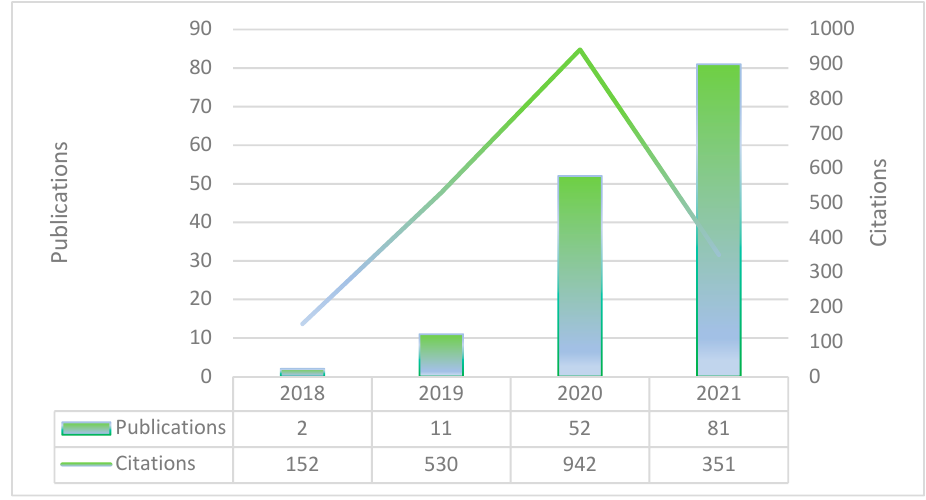
Figure 1. Citations and publications over time.